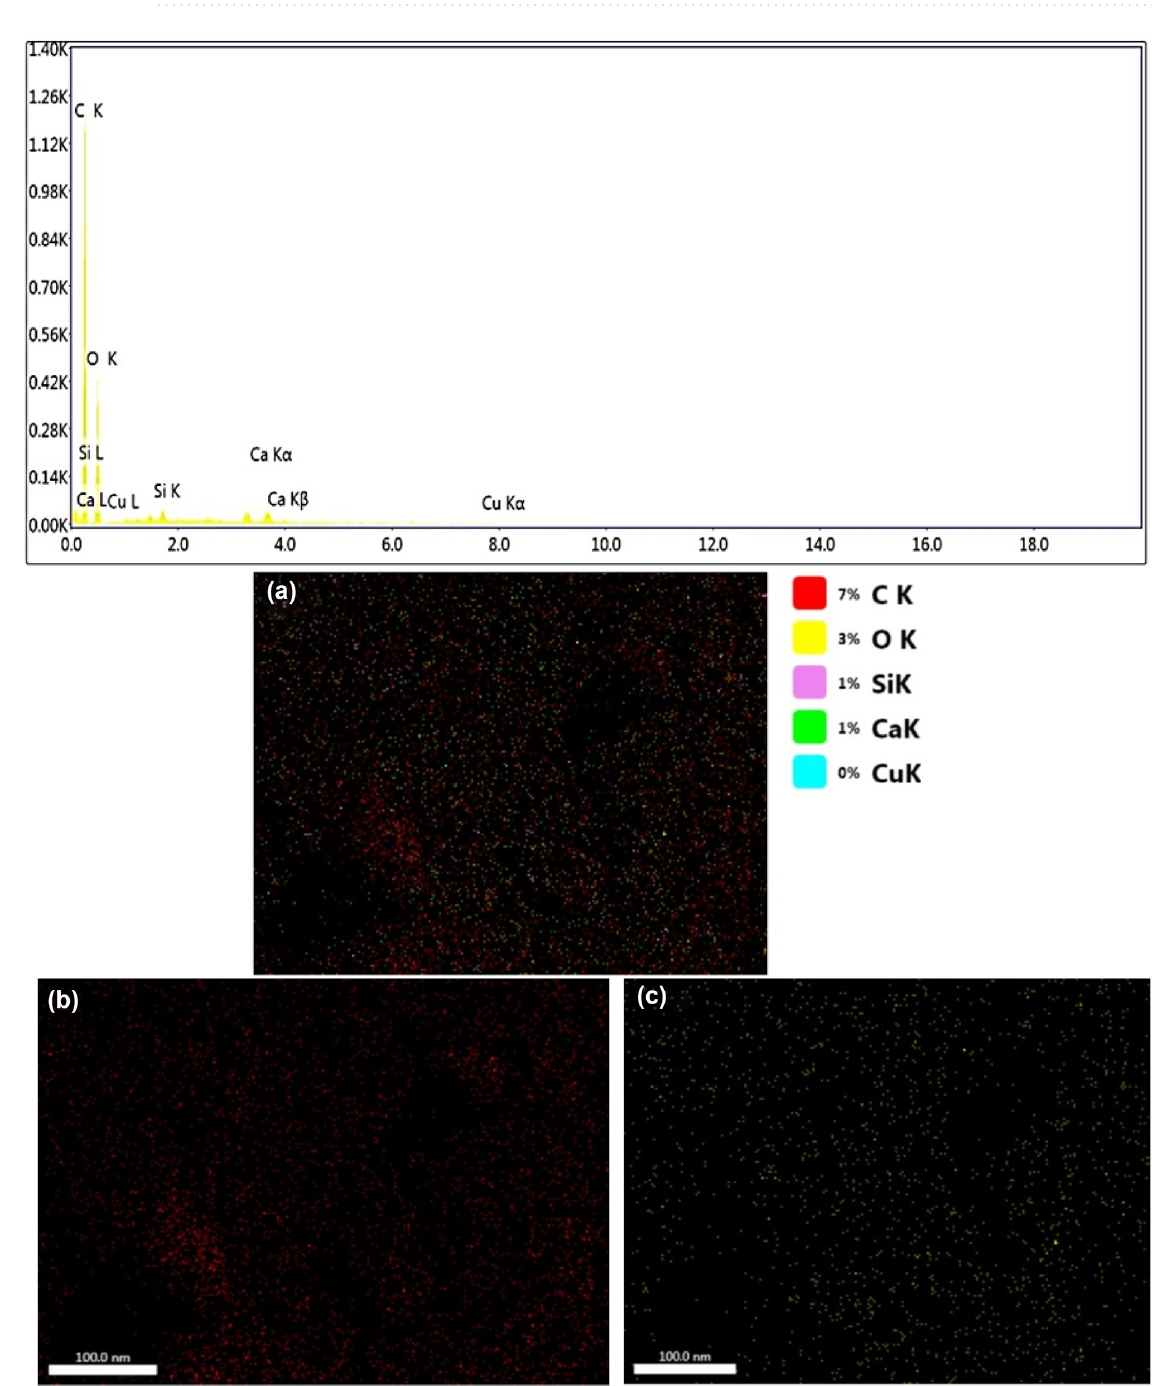
Figure 6. EDS elemental analysis scan of modern juniper. ( a ) Percentage distribution of all the identified elements; ( b ) C element; ( c ) O element; ( d ) Si element; ( e ) Ca element; ( f ) Cu